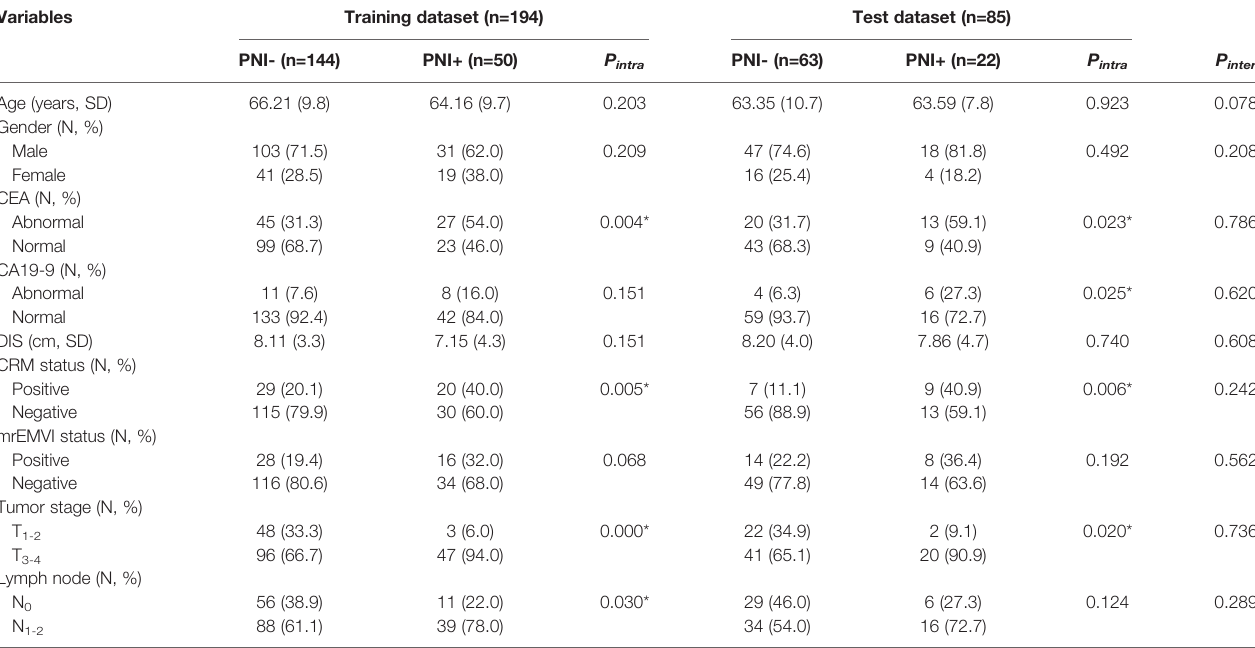
TABLE 2 | Patients ’ characteristics in the training and test